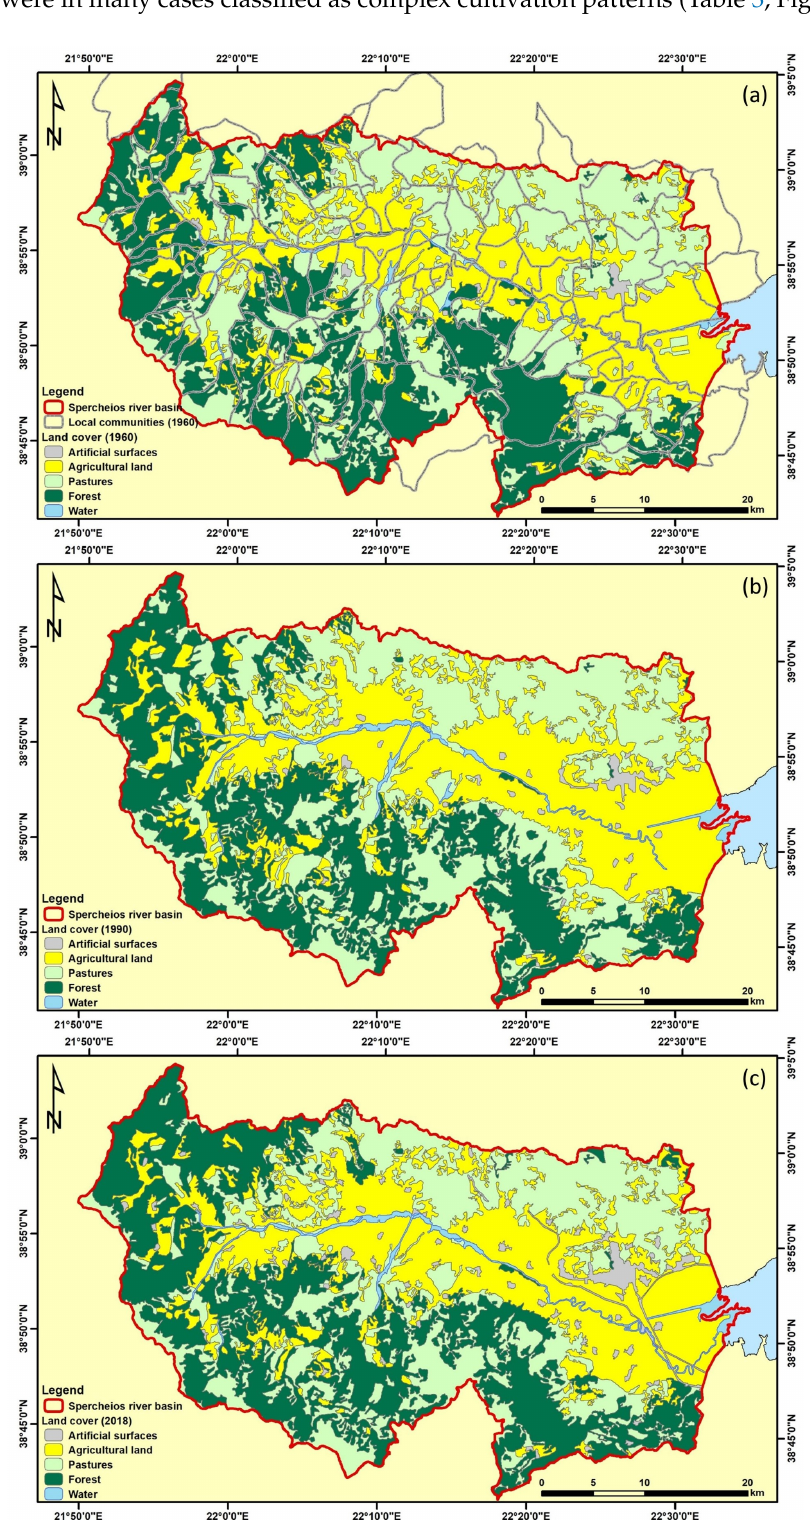
Figure 3. Land cover maps for the year: ( a ) 1960 produced for the present study, ( b ) 1990, and ( c ) 2018 from CORINE Land Cover